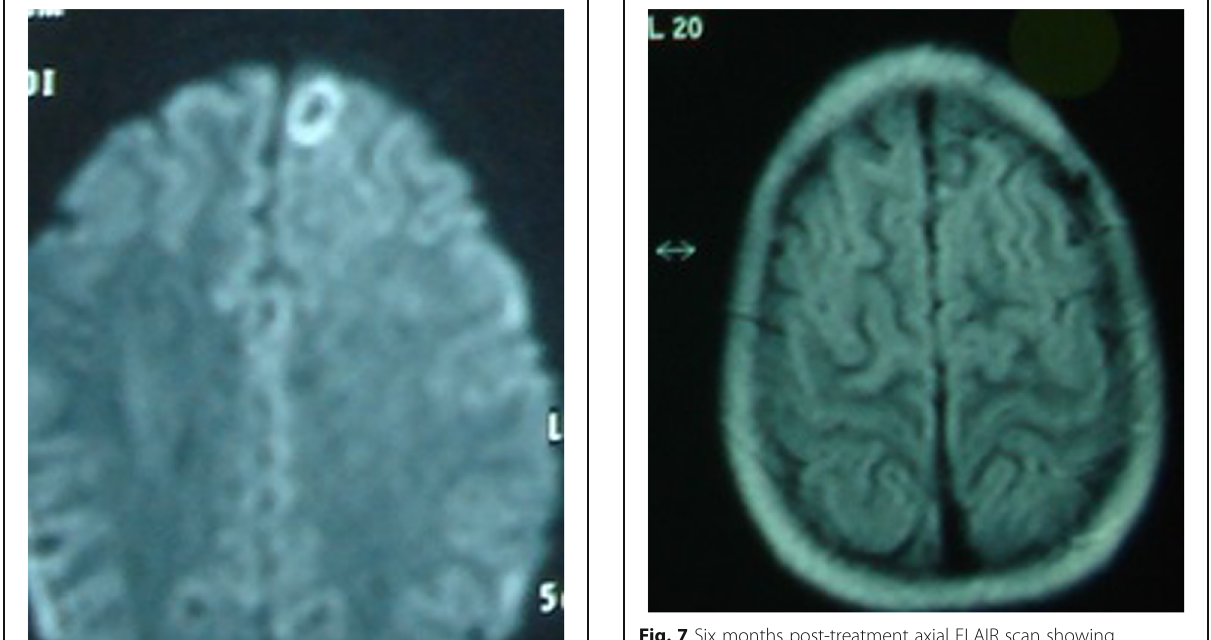
Fig. 7 Six months post-treatment axial FLAIR scan showing resolution of the perilesional vasogenic oedema with significant (more than 50%) reduction of the size of the